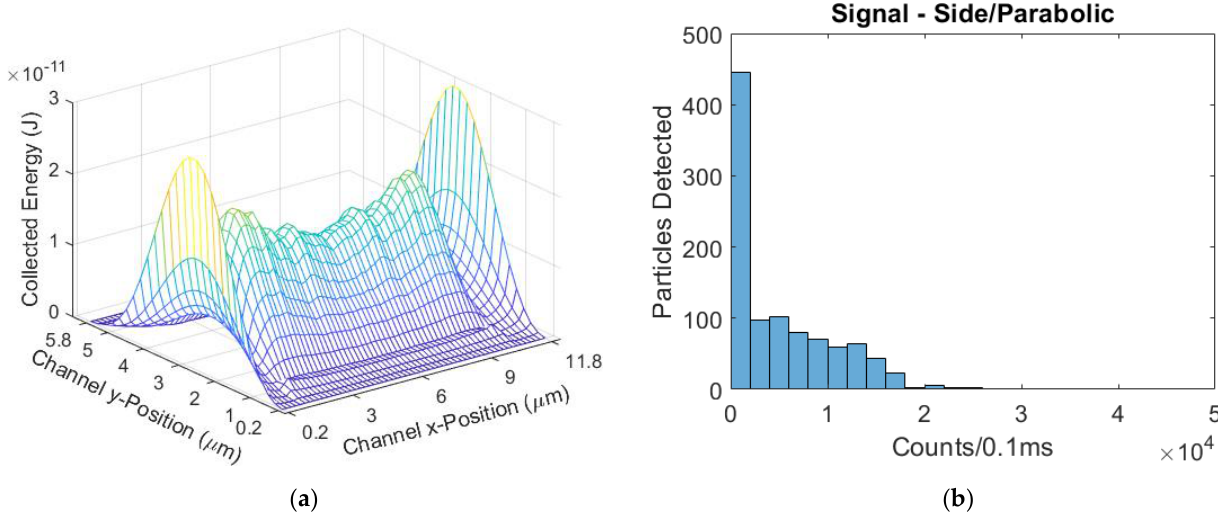
Figure 9. ( a ) The modeled excitation region for the side-illuminated biosensor with a parabolic flow regime; ( b ) The simulated signal distribution.